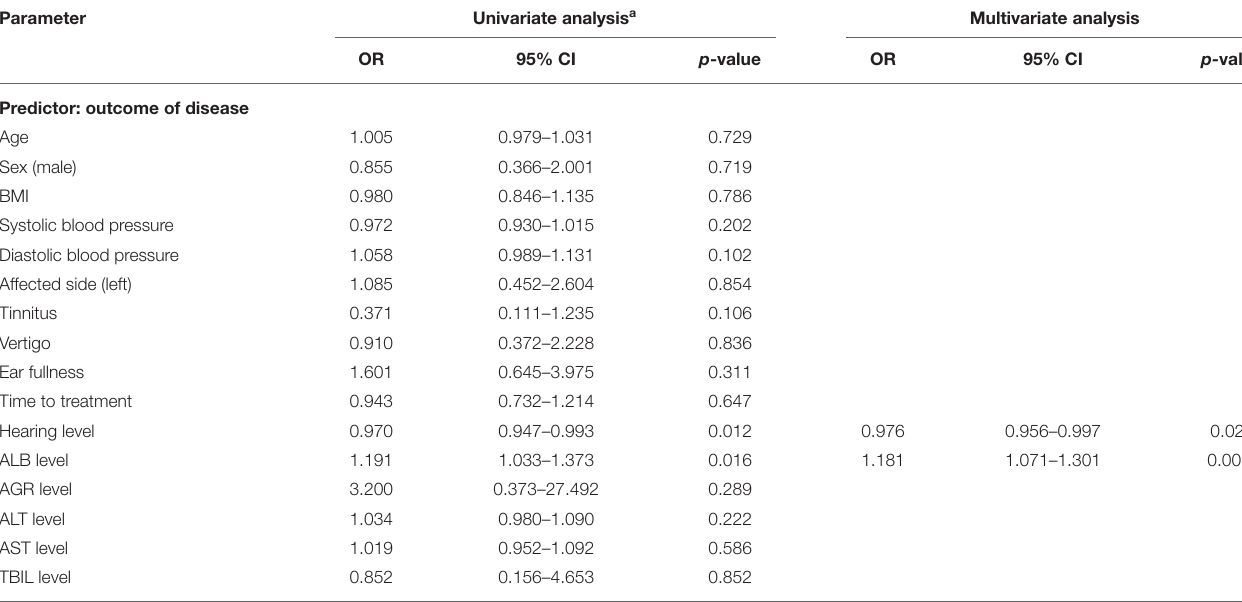
TABLE 4 | Binary logistic regression analysis of the relationship between liver function levels and the outcome of